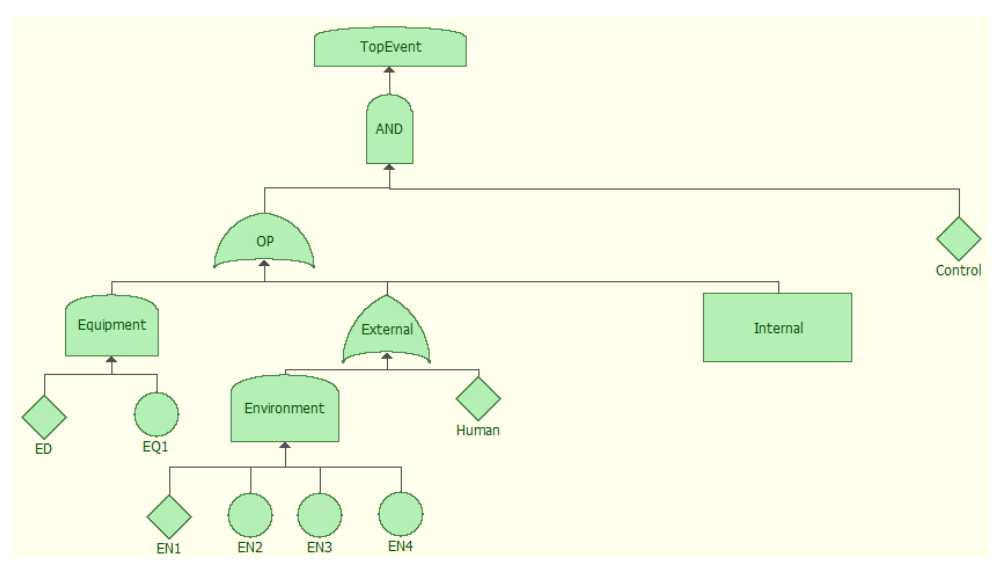
Figure 2. Top level fault tree